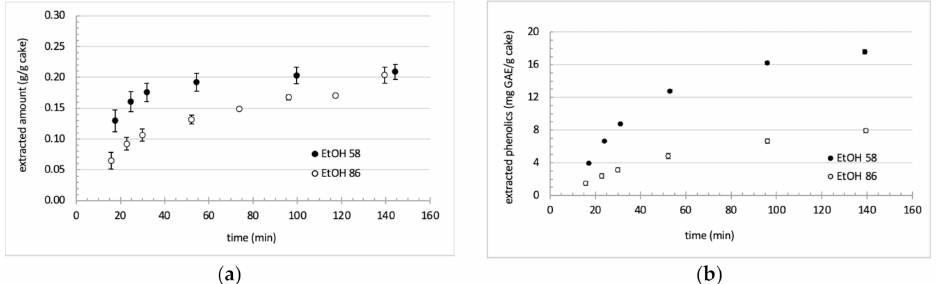
Figure 3. Extraction kinetics of ( a ) global extract and ( b ) total phenolic compounds using ethanol- based